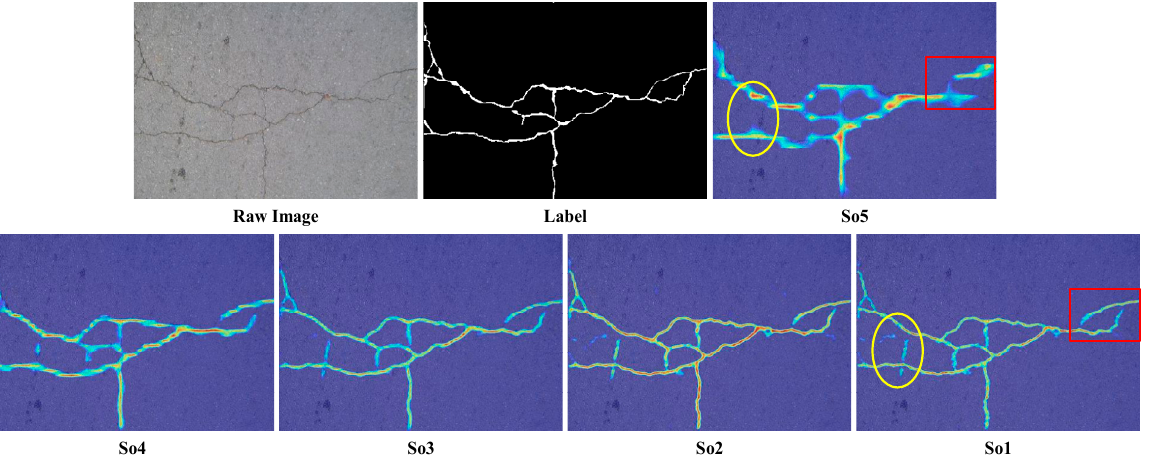
Figure 2. Visual presentation of feature heat maps of different layers. High-layer features contain more rough information of crack locations, while lower-layer features contain more details of tiny cracks (red rectangular boxes), but at the same time contain more noise (yellow ellipses). So refers to side-out.